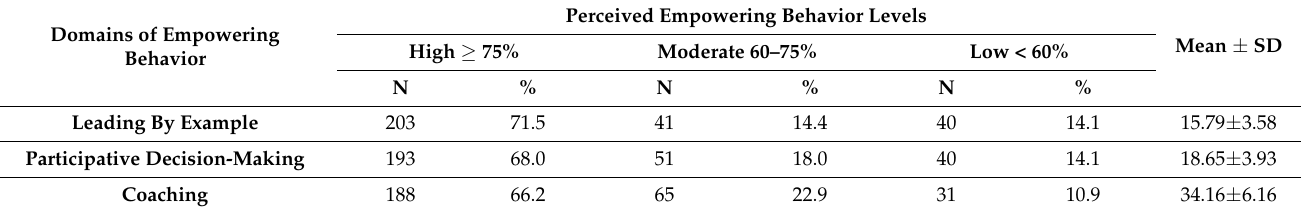
Table 4. Percentage distribution of staff nurses’ perception regarding levels of nurse manger’s empowering behavior during COVID-19 ( n =